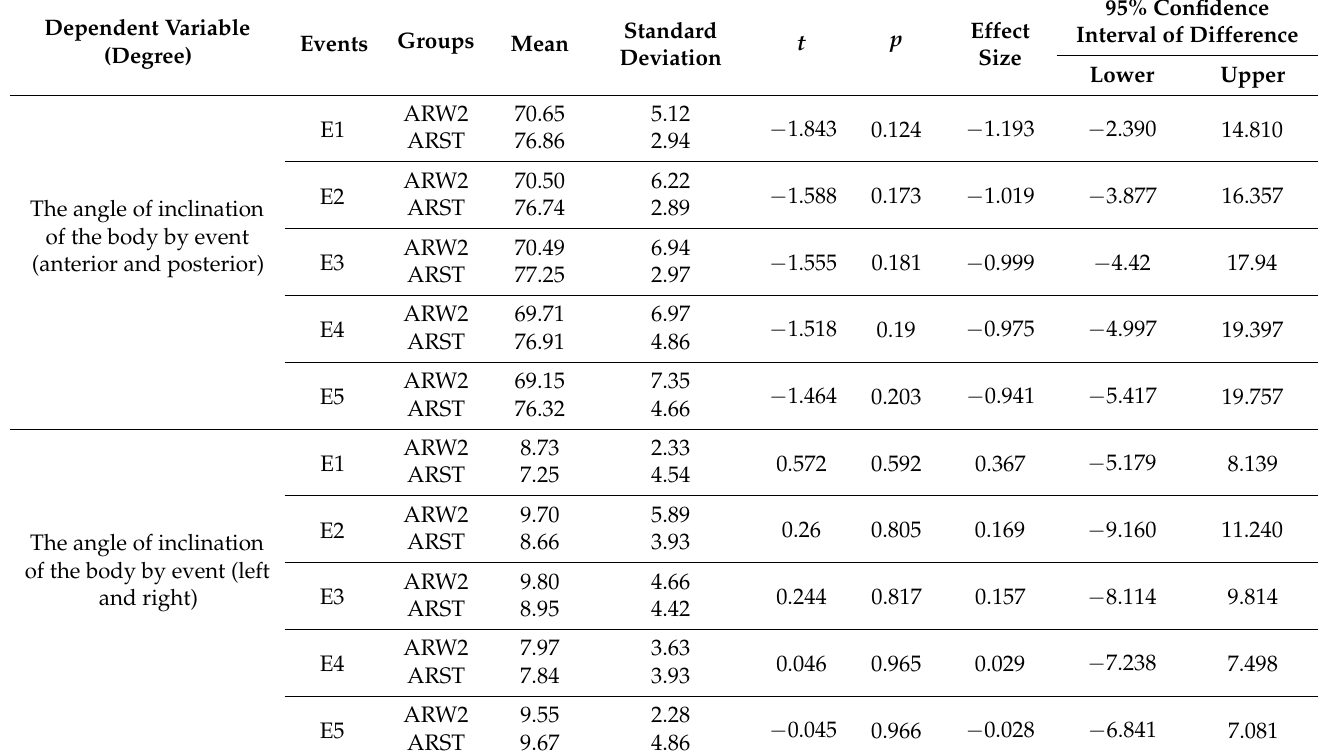
Table 4. The angle of inclination of the body by